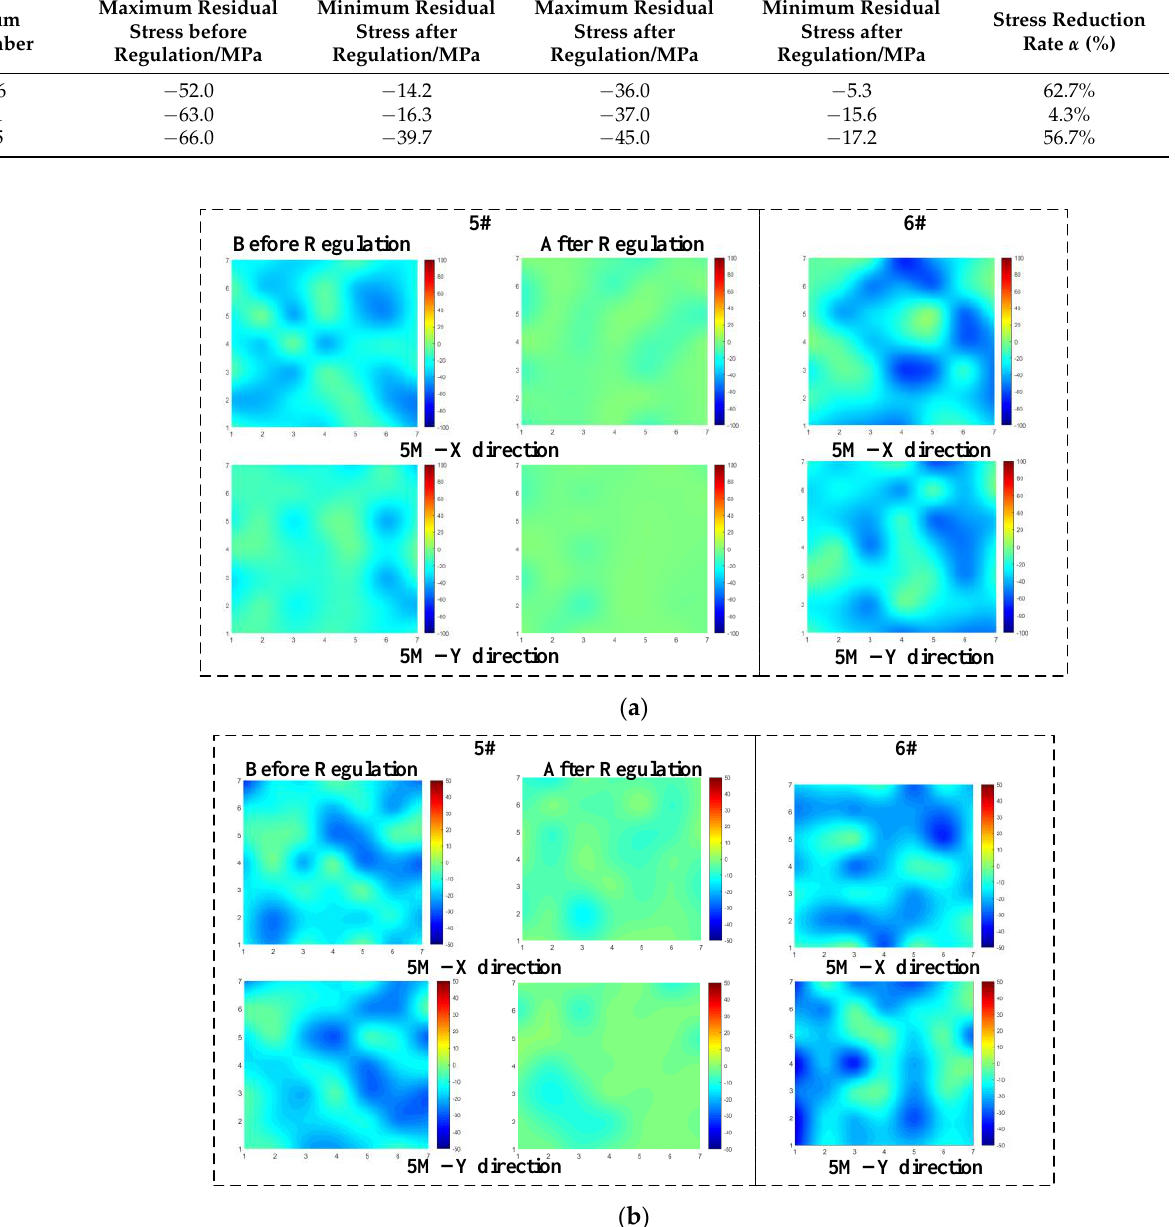
Figure 9. Residual stress cloud nephogram of 7075 aluminum alloy after milling. ( a ) 7075 alloy unilateral milling 2 mm. ( b ) 7075 alloy unilateral milling 3 mm.